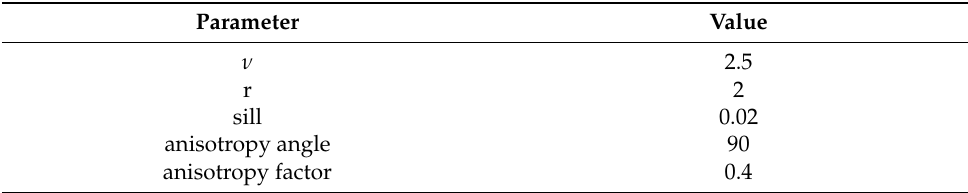
Table A2. Parameters for the Matern model in